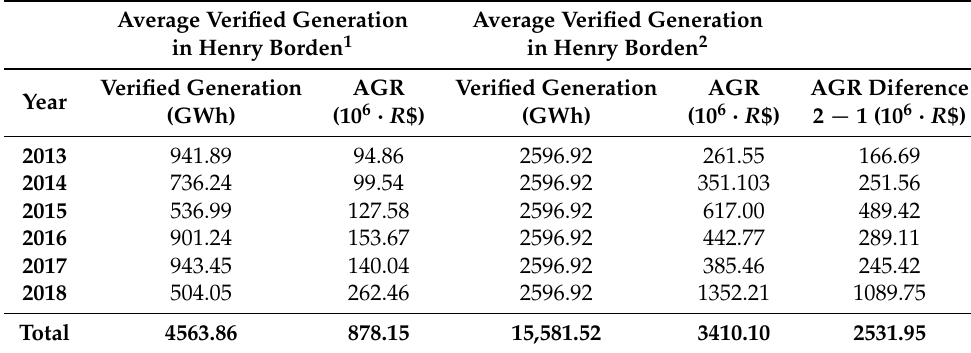
Table 4. Invoiced electricity and revenue potential of Henry Borden for Scenario